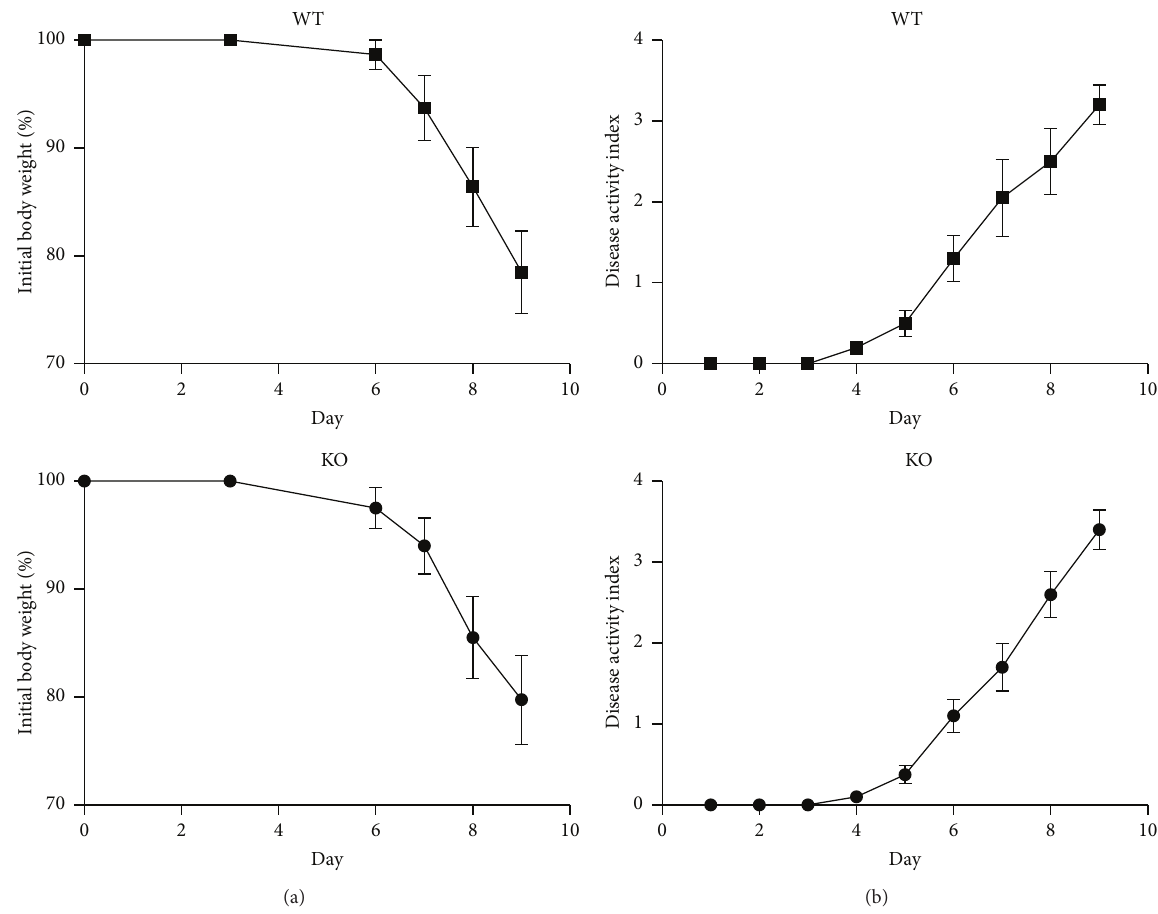
Figure 4: Mouse model of DSS colitis. Wild-type (WT) and Cyp4f18 knockout (KO) mice were treated with 4% DSS in drinking water for 9 days, and the change in body weight (a) or disease activity index (b) was measured each day. There were no significant differences between WT and KO mice (data shows mean values ± SEM, 𝑛 = 10 , 𝑃 > 0.05 ).